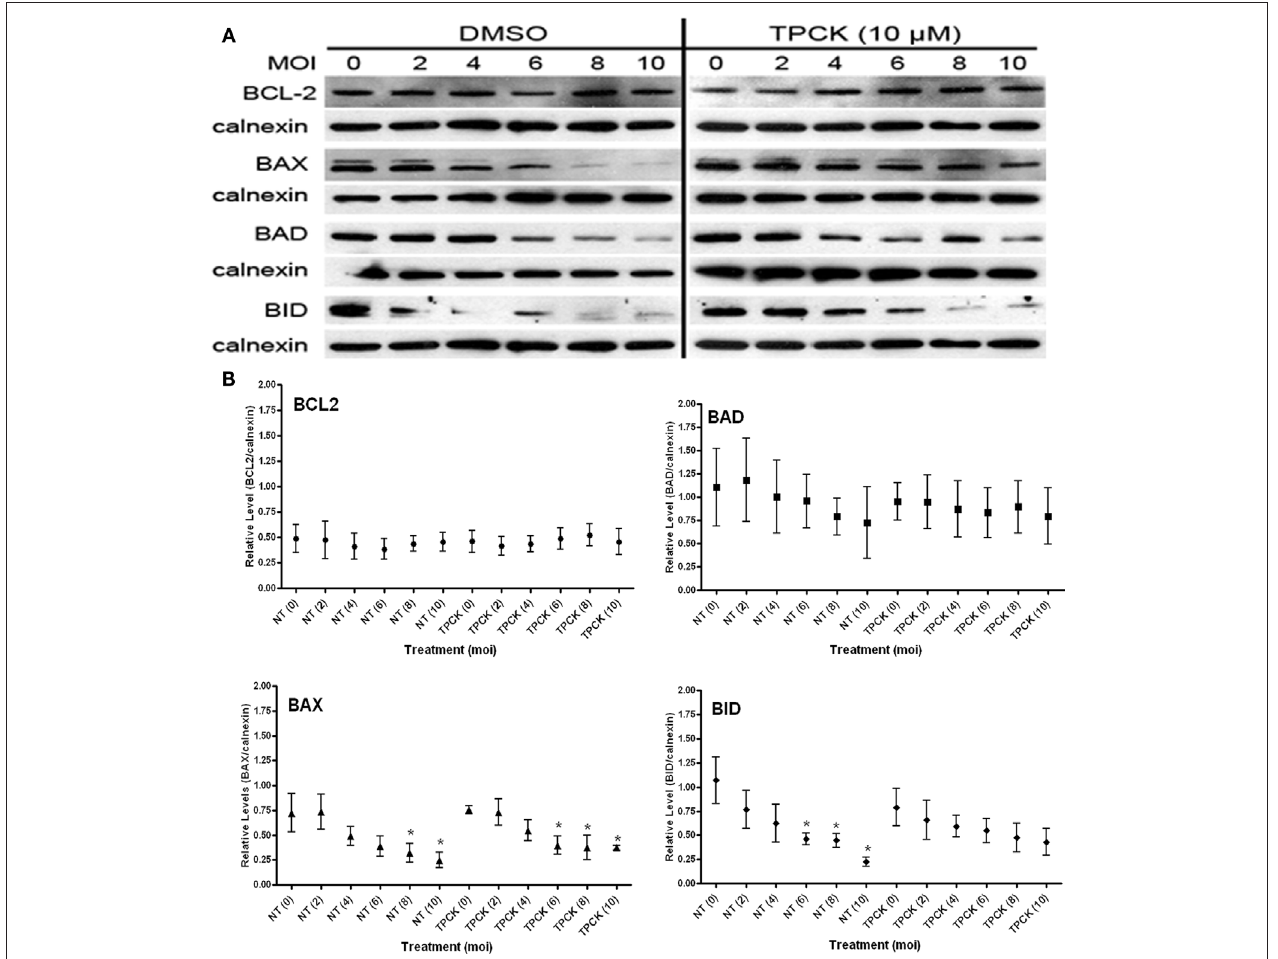
Figure 6 | effect of chymotrypsin-like serine protease inhibition with TPCK on the steady state levels of BCL2-family proteins in both uninfected (MOi = 0) and infected cells (MOi 2–10). (A) Representative immunoblots detecting the levels of the indicated BCL2-family members in response to increasing infection. Levels of calnexin are used as a loading control. (B) Quantification of the levels of specific BCL2-proteins relative to calnexin in response to increasing infecting dose. Profiles for no-treatment (NT, untreated) and treated (TPCK) samples are indicated along with the MOI in